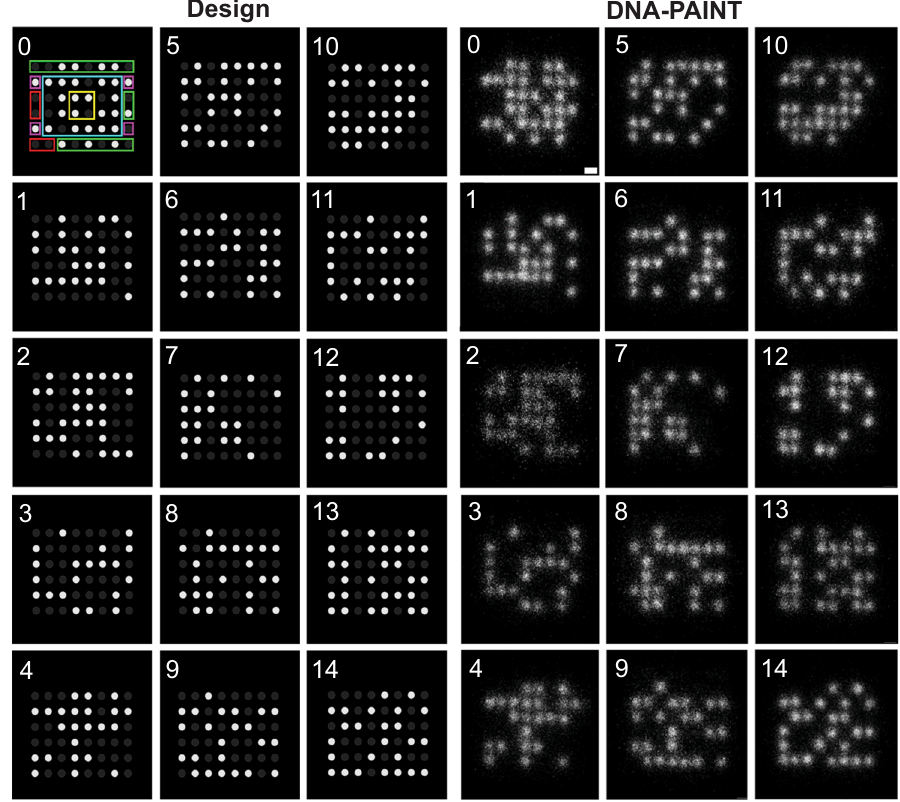
Fig. 2 DNA-PAINT imaging of dNAM indicates all sites are recovered in a single read. dNAM origami from a DNA-PAINT recording were identi fi ed and classi fi ed by aligning and template matching them with the 15 design matrixes (Design) in which all potential docking sites are shown. Filled circles indicate sites encoded ‘ 0 ’ (dark gray) or ‘ 1 ’ (white). Colored boxes indicate the regions of the matrixes used for the droplet (green), parity (blue), checksum (yellow), index (red), and orientation (magenta). For clarity, only the fi rst design image includes the colored matrix sites. Averaged images of 4560 randomly selected origami, grouped by index, are depicted (DNA-PAINT). Scale bar, 10